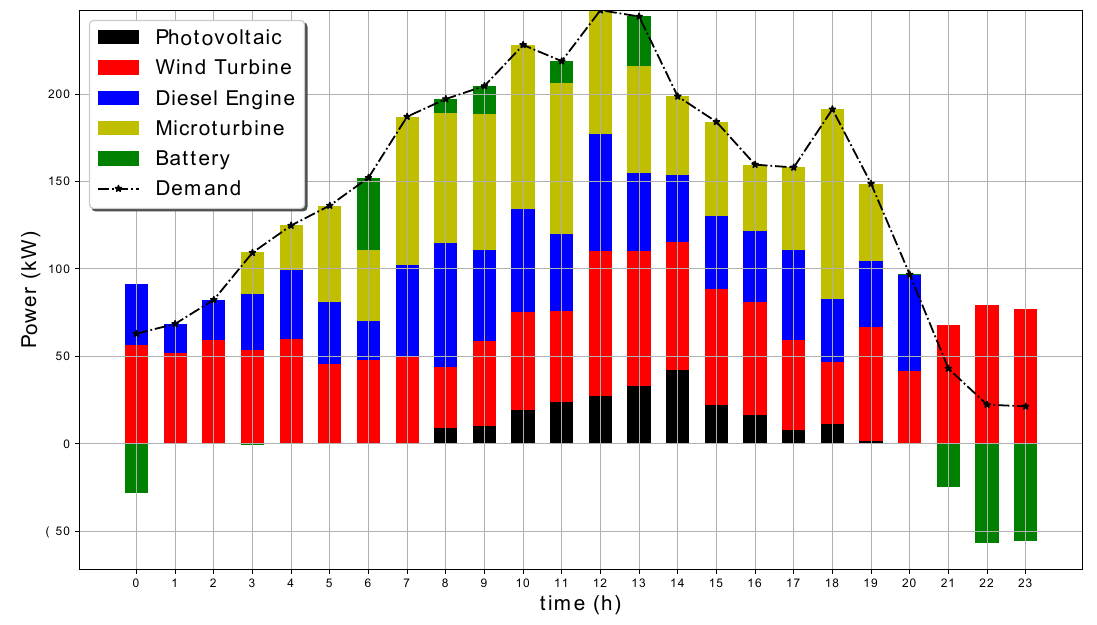
Figure 4. Optimal power scheduling for the time period considered.